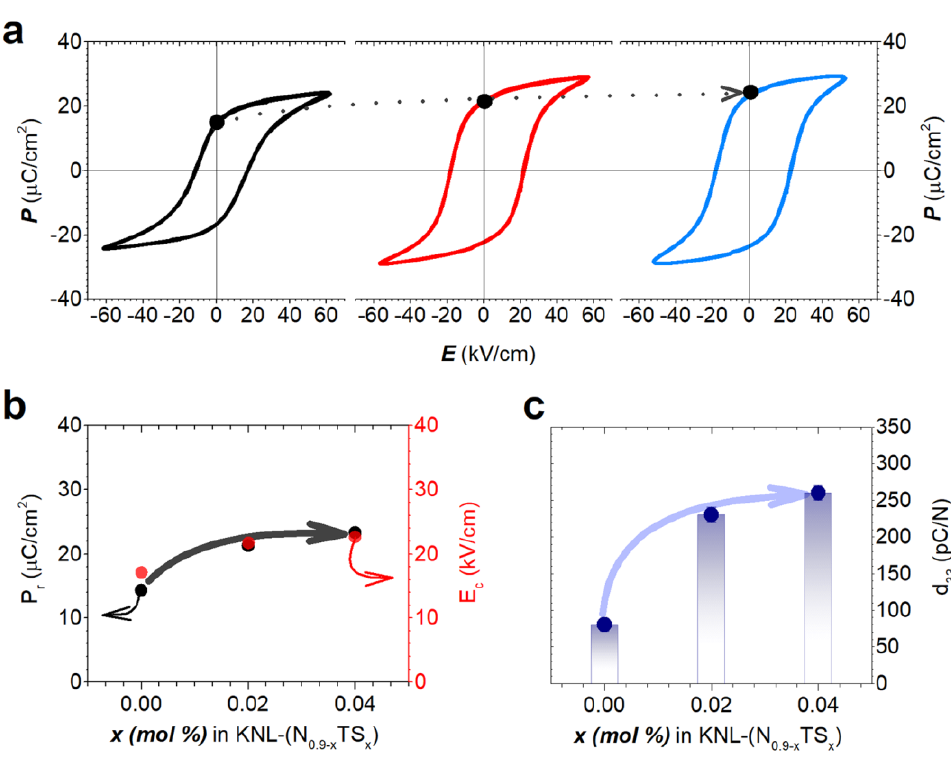
Figure 6. Ferroelectric loop of the KNL − (N 0.9 − x TS x )ceramics ( a ). Pr and Ec ( b ), and d 33 ( c ) evolution with antimony addition.